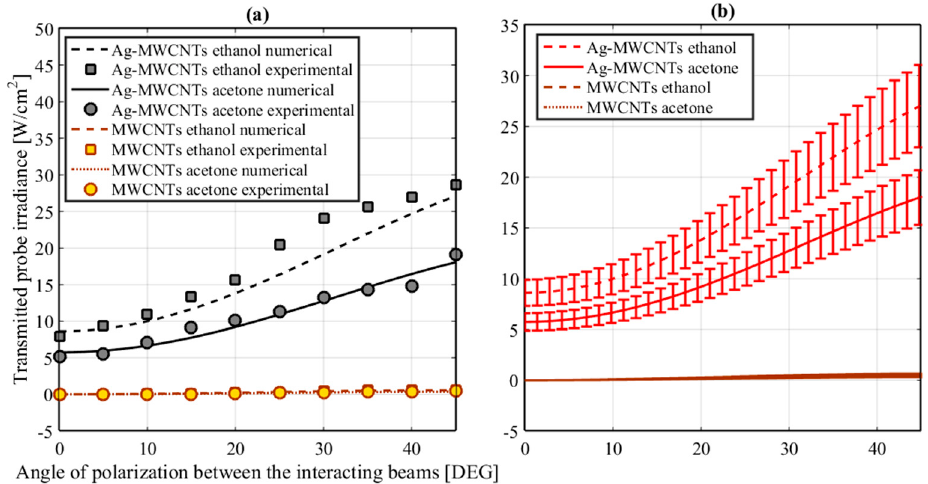
Figure 4. ( a ) Transmitted probe irradiance as a function of the angle between the planes of polarization of the incident beams in the nanofluids tested in the vectorial TWM. ( b ) Experimental error bars for ( a